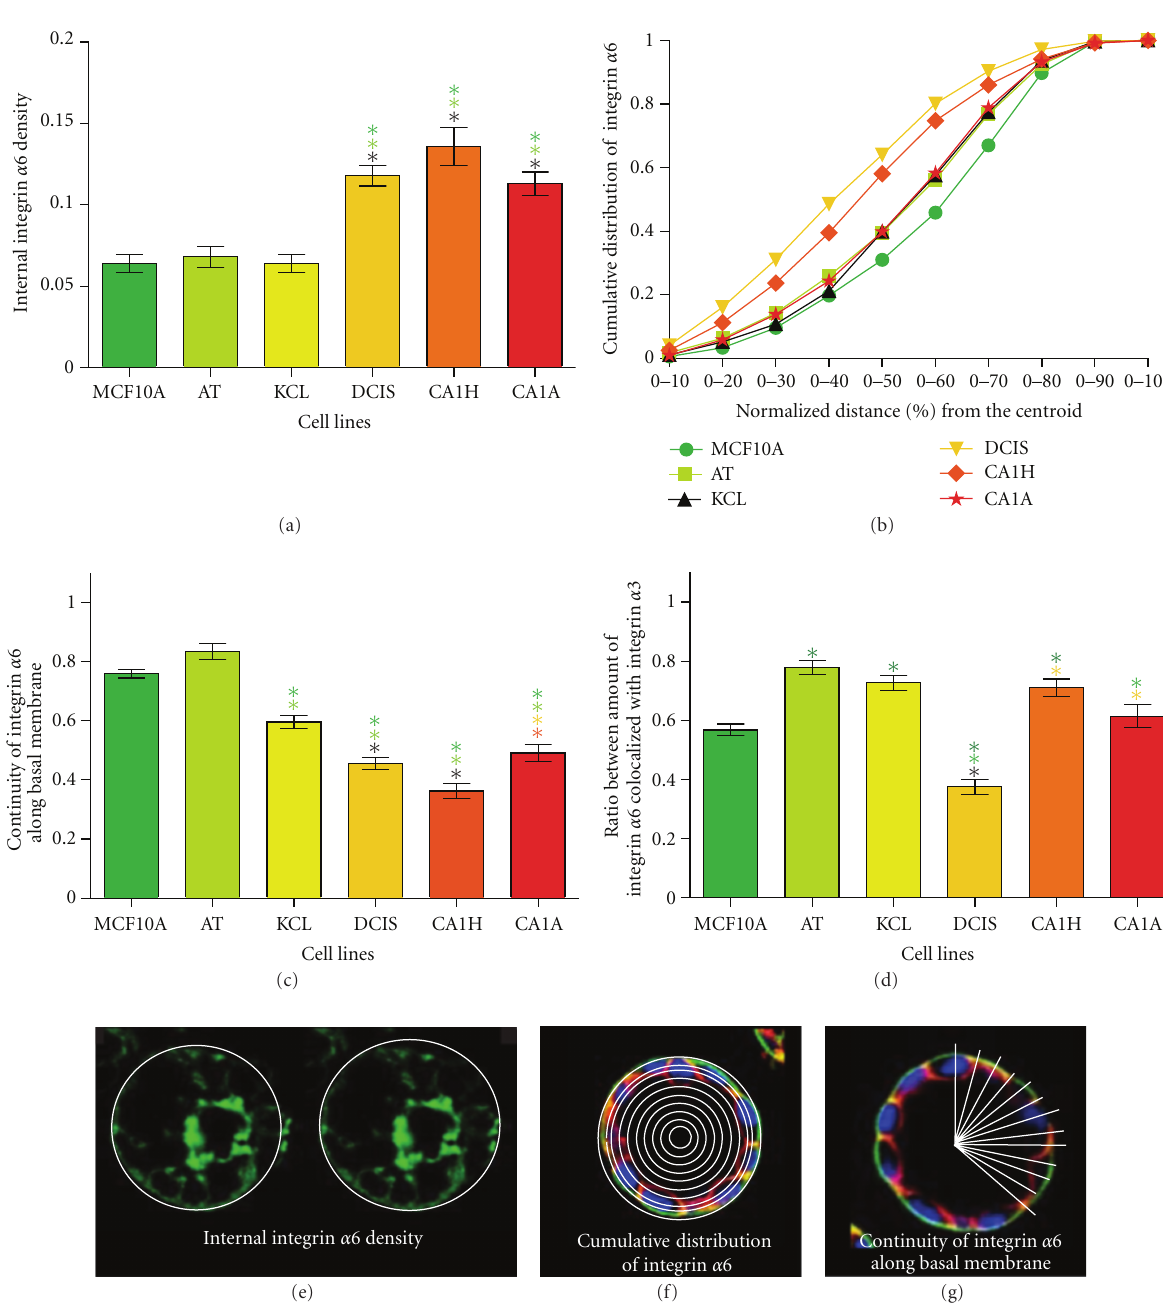
Figure 5: Features capturing the level of cell polarity based on the basal membrane protein integrin α 6 density. (a) shows the internal integrin α 6 density that is computed as illustrated in (e) where the amount of integrin α 6 localized inside the acini is divided to the total amount of integrin α 6, (b) shows the cumulative spatial distributions of integrin α 6 that is computed as illustrated in (g) where the amount of integrin α 6 localized within the concentric circles are divided by the total amount of integrin α 6 within the acini, (c) shows the continuity of the integrin α 6 along the basal membrane that is measured as illustrated in (f) where the number of times that rays initiate from the centroid oriented at from 1 to 360 degrees intersected with the green fluorophores along the basal membrane is counted and normalized between 0 and 1, and (d) shows the ratio between the amount of integrin α 6 colocalized with integrin α 3 and the total integrin α 6 expression. Error bars correspond to the standard error of the means. Two-sided t -tests were performed and cell lines that exhibit statistically significance ( P < 0 . 05) are marked with asterisks ( ∗